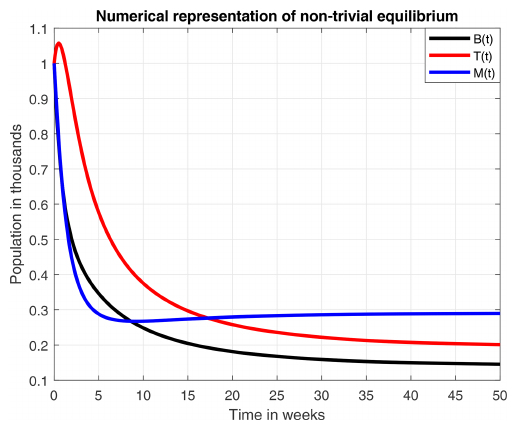
Figure 6. Numerical representation of the equilibrium E 1 . Here, λ ∗ = 1 . 195 and ν =